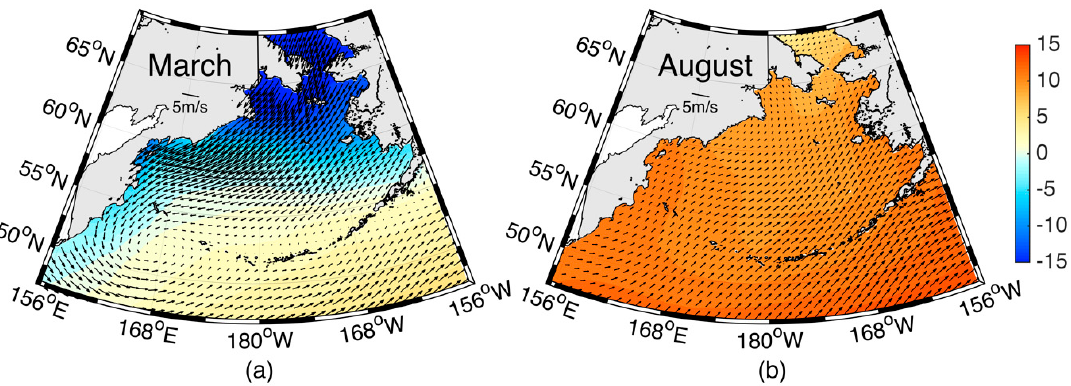
Figure 7. Seasonal variation in the air temperature ( Unit: ℃ ) and wind at the sea surface in the Bering Sea: ( a ) March and ( b ) August, which are from the National Center of Environmental Prediction (NCEP) reanalysis product and averaged over 15 years (1990–2004).